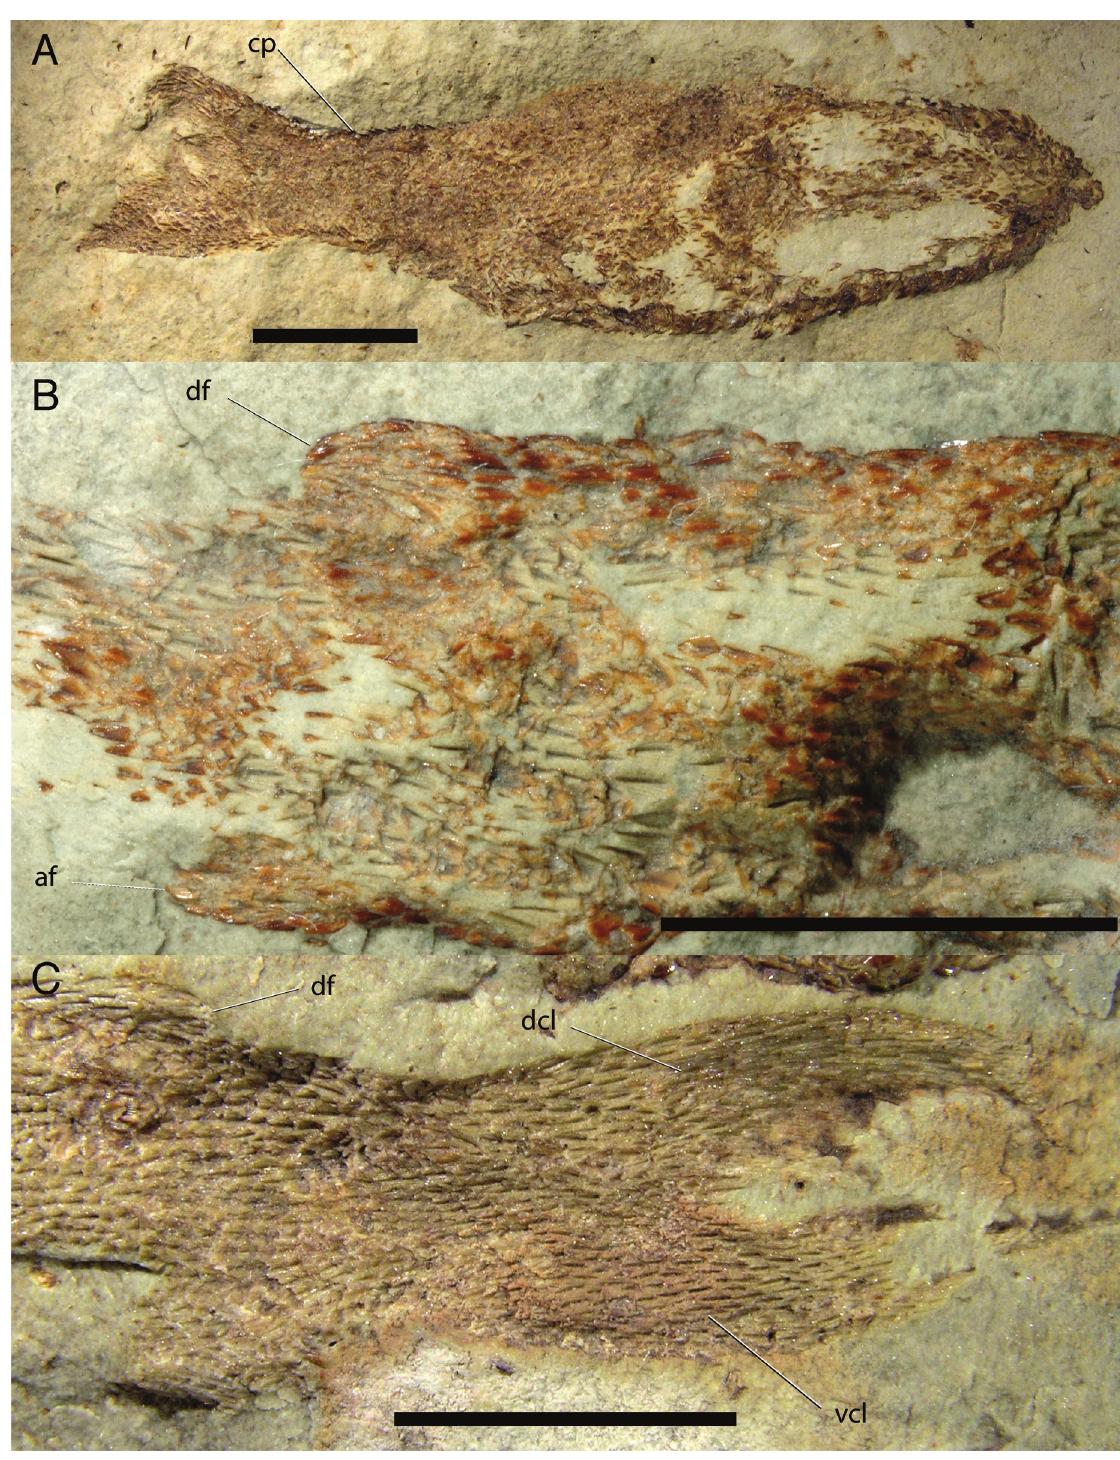
Fig. 7. Phlebolepis elegans Pander. Specimens illustrating the trunk and dorsal and anal fins, from Himmiste-Kuigu, Saaremaa, Estonia, imaged wet. A , TUG 865-4-1, illustrating the proportions and shape of the trunk and caudal peduncle; B , TUG 865-3-2, with dorsal and anal fins; C , TUG 865-5-21, dorsal fin, caudal peduncle and caudal fin with converging main lobes. Scale bars are each 1 cm. Abbreviations: af, anal fin; dcl, dorsal caudal lobe; df, dorsal fin; cp, caudal peduncle; vcl, ventral caudal